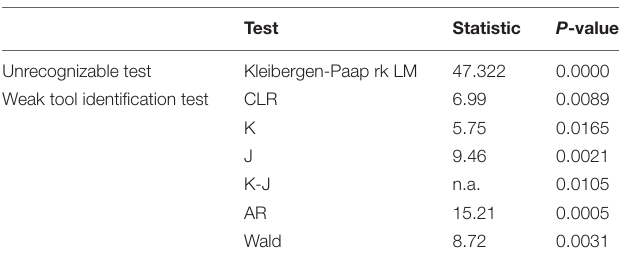
TABLE 6 | Ivprobit